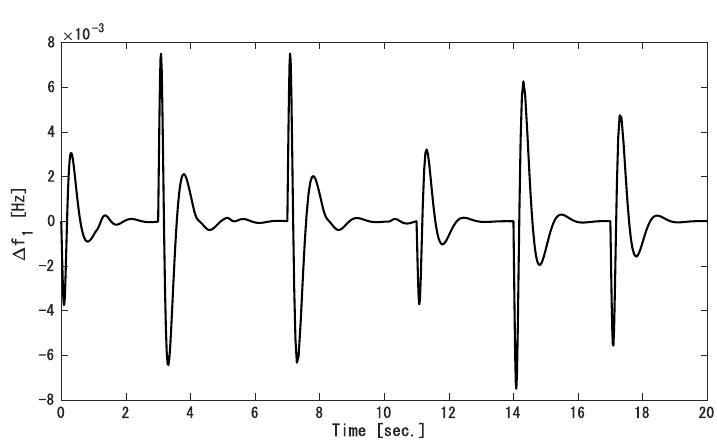
Figure 13. Random load variation.